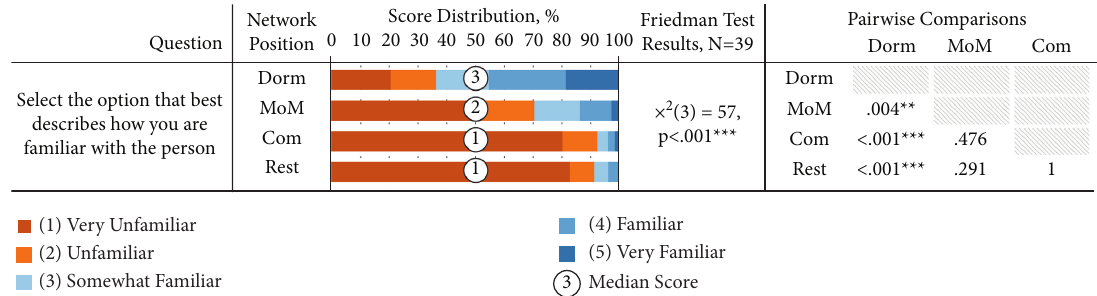
Figure 6: Proportions of perceived familiarity levels across different structural positions. 72 recommendations per position. Significance codes: 0 “ ∗∗∗ ” 0.001 “ ∗∗ ” 0.01 “ ∗ ” 0.05 “” 0.1.